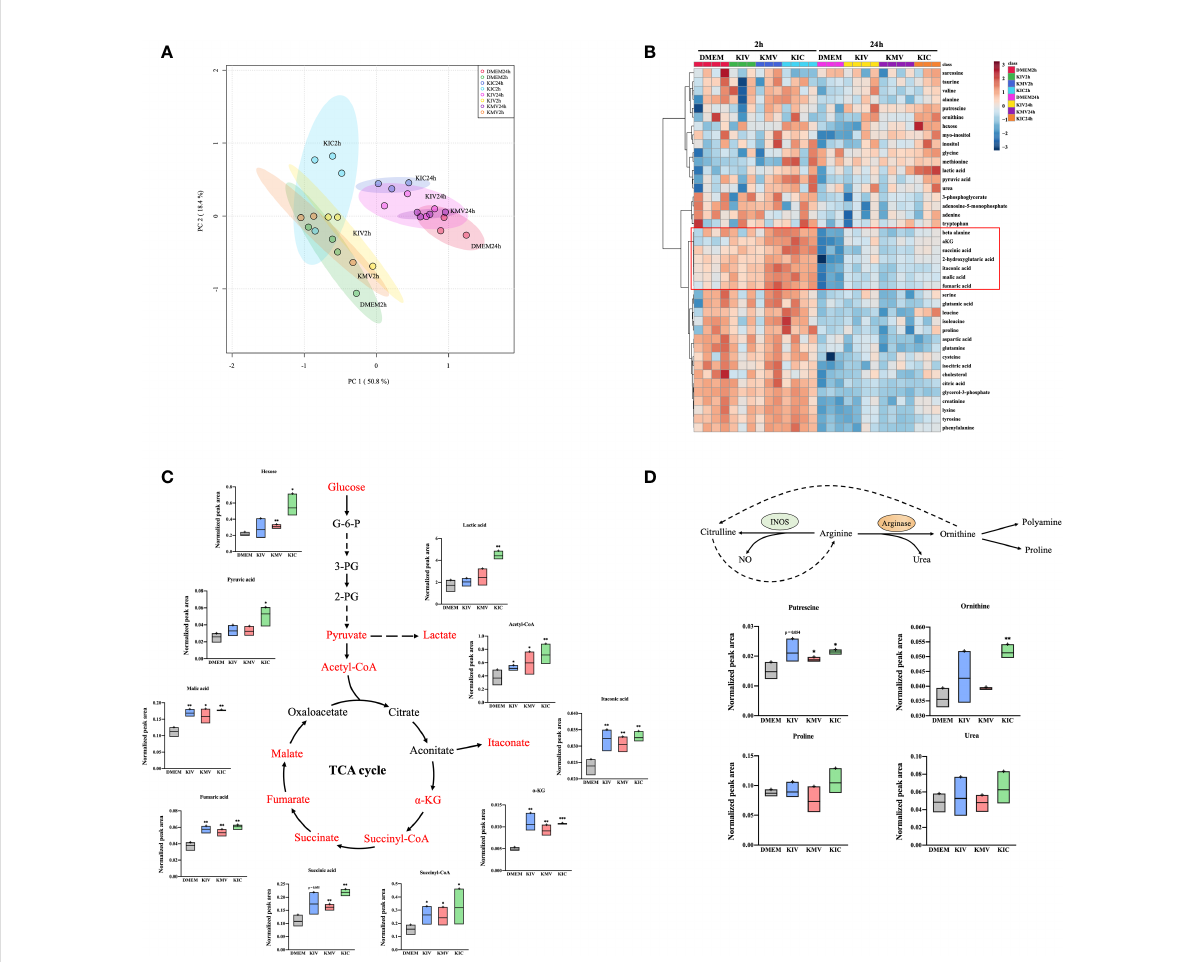
FIGURE 4 BCKAs stimulation enhance TCA cycle and polyamine metabolism in macrophages. (A) , PCA analysis of total identi fi ed metabolites among DMEM, KIV, KMV and KIC treatment at two time points (2 h and 24 h) is shown. (B) , The hierarchal clustering heatmap of identi fi ed metabolites upon DMEM and three BCKAs treatment at two time points (2 h and 24 h) is shown. The rows indicate different metabolites, and the columns indicate different conditions. The log-transformed metabolite intensities (normalized to internal standards) were scaled by autoscaling (mean- centering/standard deviation). (C) , Schematic representation of the TCA cycle, the corresponding metabolite is shown. (D) , Schematic representation of the arginine metabolism at 24 h, the corresponding metabolites from (B) are shown. PCA (A) and hierarchical clustering (B) analysis were applied via online tool MetaboAnalyst. Data shown the mean ± SEM of n = 3 or 4 biological experiments. * p < 0.05, ** p < 0.01, *** p < 0.001 (unpaired two-tailed t test) (unpaired two-tailed t